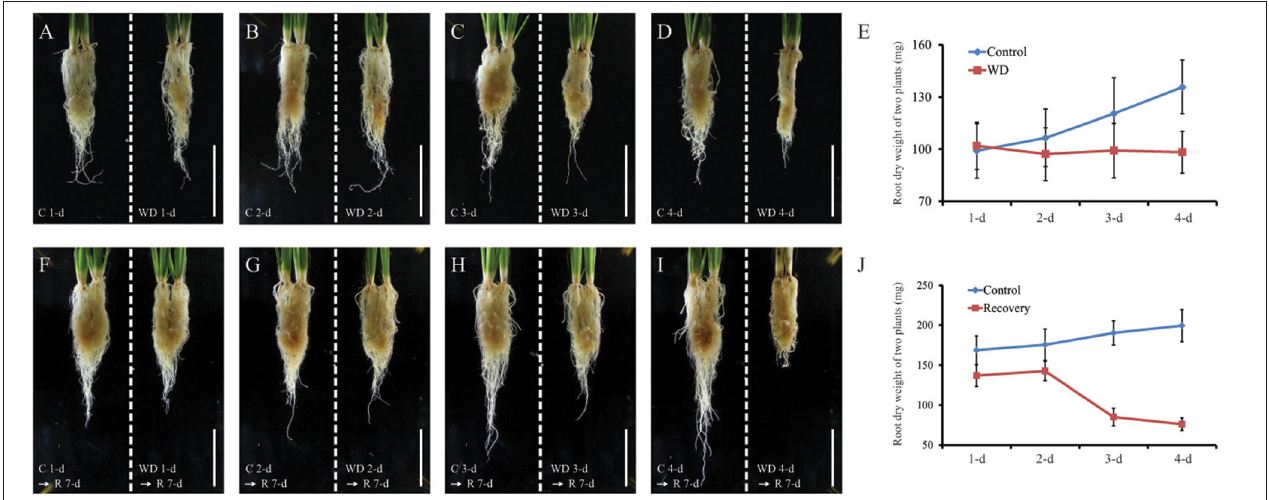
FIGURE 2 | Physiological responses under drought stress of rice roots grown in soil. The plants grown for 4 weeks was exposed WD for 1, 2, 3, or 4 d and the dry weight was measured in roots (A–E) . After 7-d of recovery, dry weight was measured (F–J) . C1, C2, C3, and C4, untreated control (roots from well-watered